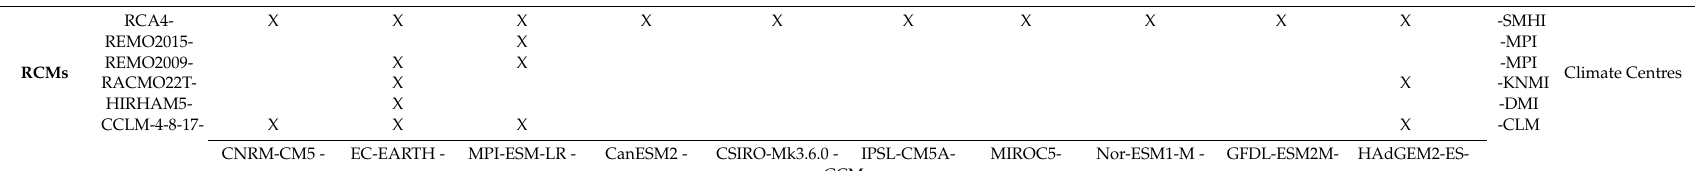
Table 2. Matrix of CORDEX Africa models used in the study. The matrix consists of ten Global Climate Models (GCMs) and five Regional Climate Models (RCMs) from five centers: Swedish Meteorological and Hydrological Institute (SMHI), Sweden, Max Planck Institute (MPI), Germany, The Royal Netherlands Meteorological Institute (KNMI), Netherlands, The Danish Meteorological Institute (DMI), Denmark, and Climate Limited-Area Modeling Community (CLM),